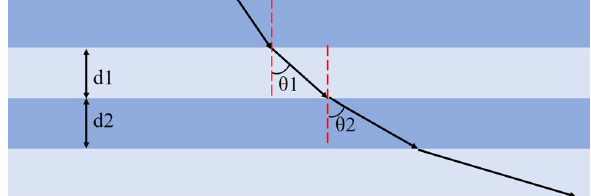
Figure 7 Multilayer diffraction of photonic